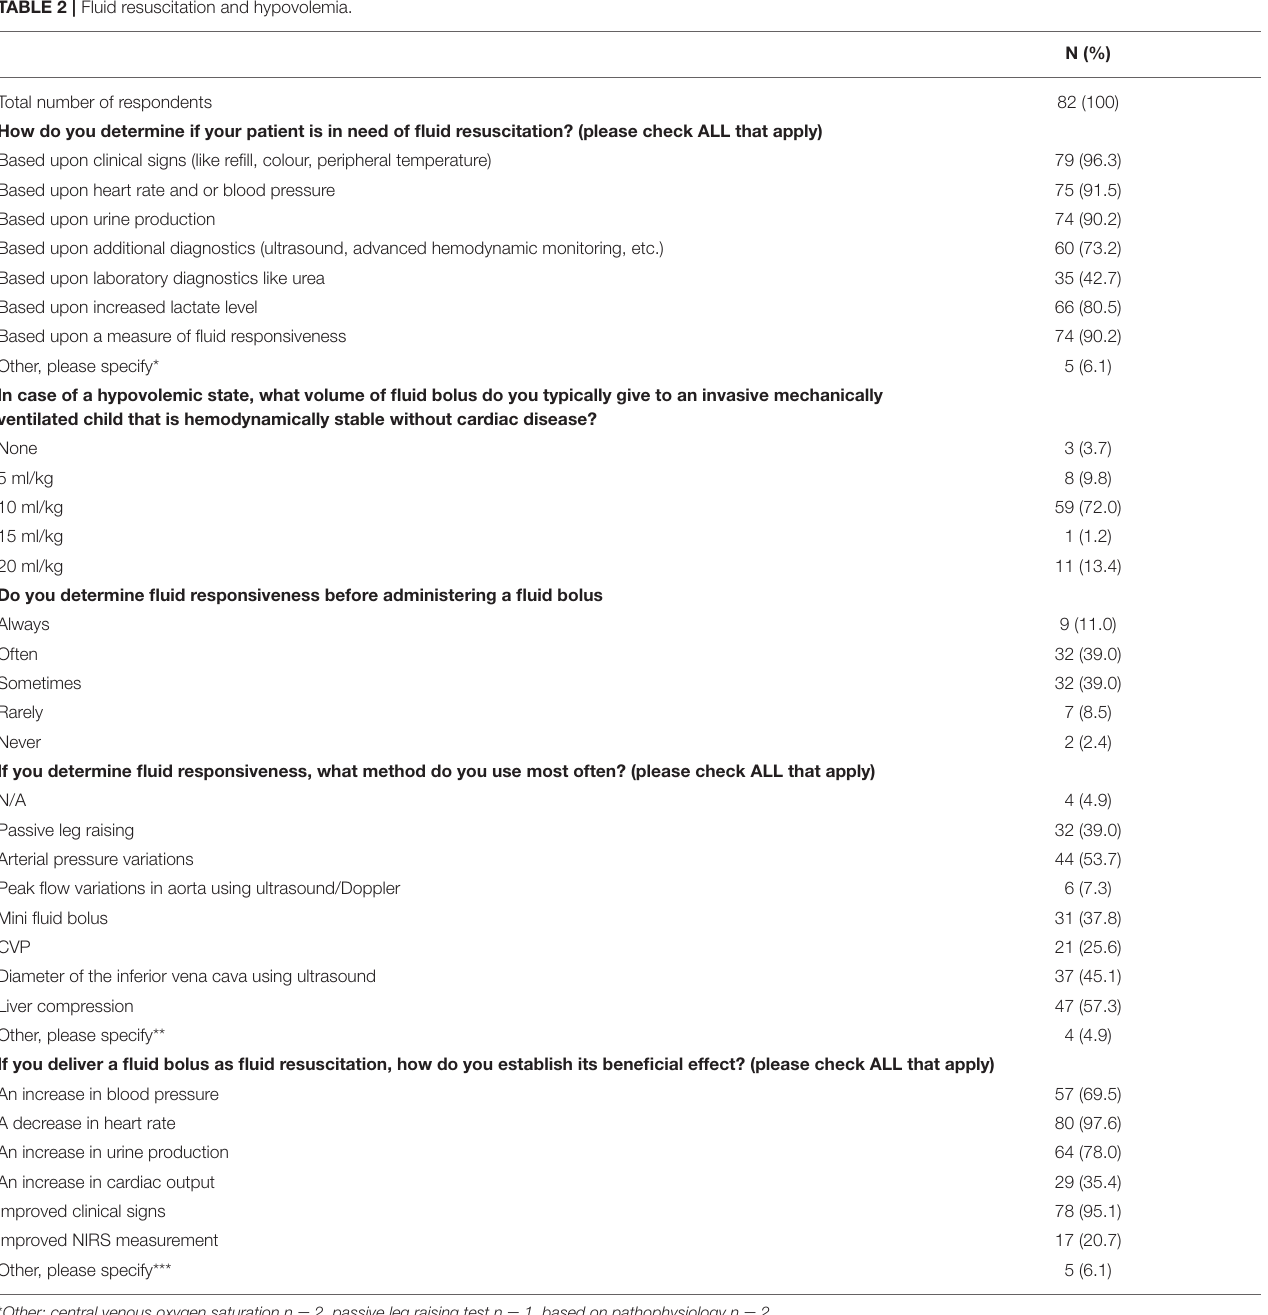
TABLE 2 | Fluid resuscitation and